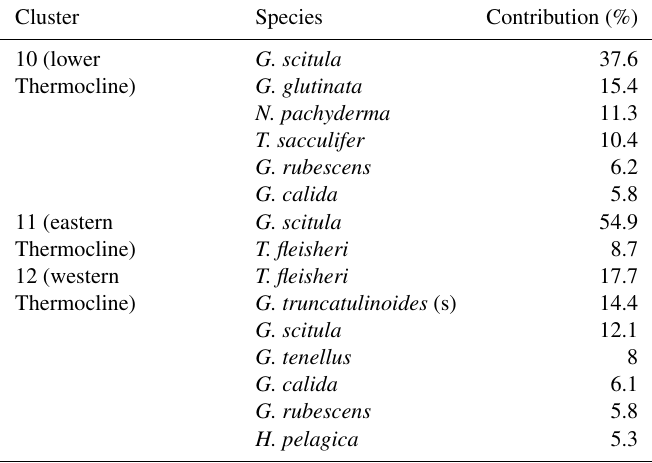
Table 3. Contribution of most abundant planktonic foraminifera species ( > 5%) in each cluster (given by average relative abun-